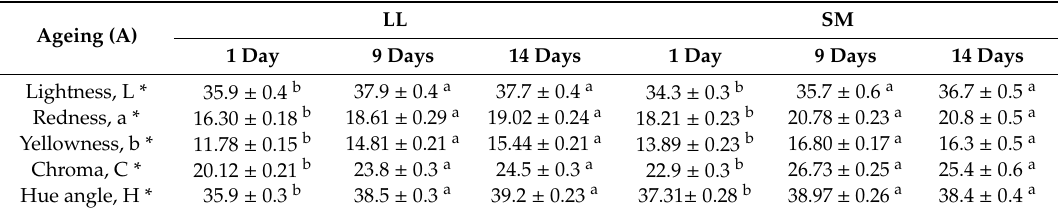
Table 3. The influence of ageing time on color parameters of LL and SM muscles (n = 24) (mean values ±